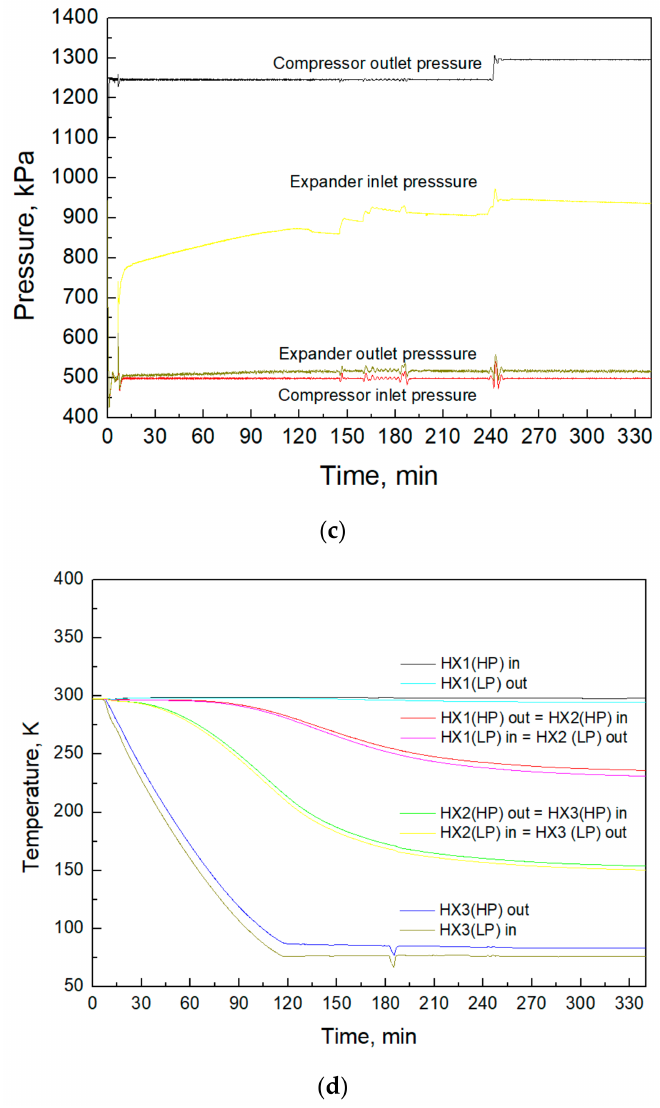
Figure 5. Measurement results of the cool-down performance test: ( a ) temperature of the system, ( b ) mass flow rate and pressure of the bu ff er tank, ( c ) inlet and outlet pressures of the compressor and turbo-expander, and ( d ) temperature of the heat